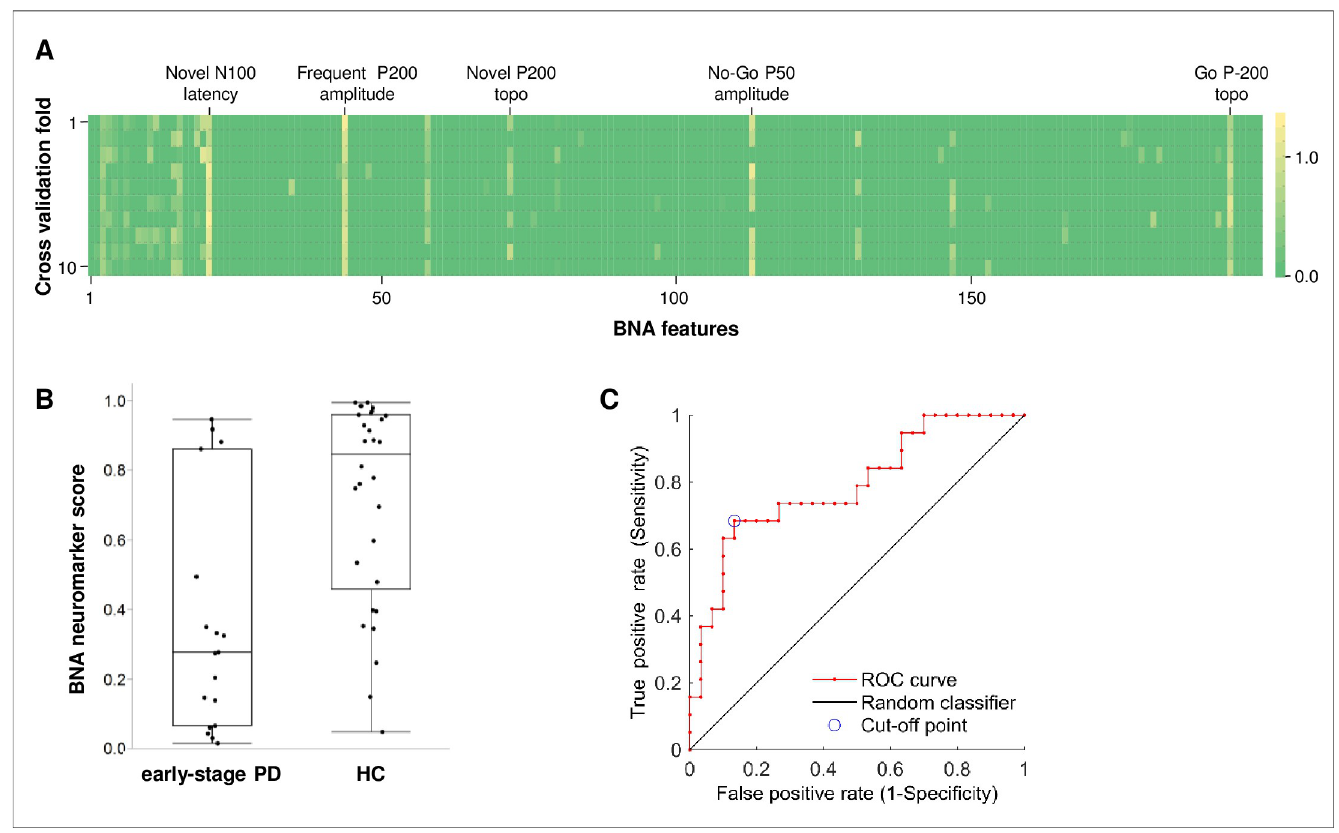
Fig 1. The BNA neuromarker characteristics. (A) Weights of each feature in each iteration (fold) of the cross-validation process. The consistency of the selected features in each fold can be observed. The names of the 5 most important features of the final model are indicated at the top. (B) BNA neuromarker scores for participants in the ESPD and the HC groups. The scores were obtained from the cross-validation process and represent [1- probability for ESPD]. Whiskers extend to the highest and lowest observations, boxes represent 25–75 interquartile ranges, and horizontal bars represent medians. Mann-Whitney U test (normal approximation): U = 120, Z = -3.38, p-value = 0.0007. (C) Receiver-operating characteristic (ROC) curve for the BNA neuromarker. The cross-validation scores were used for the ROC analysis. topo, topographic similarity; PD, Parkinson’s disease; HC, healthy